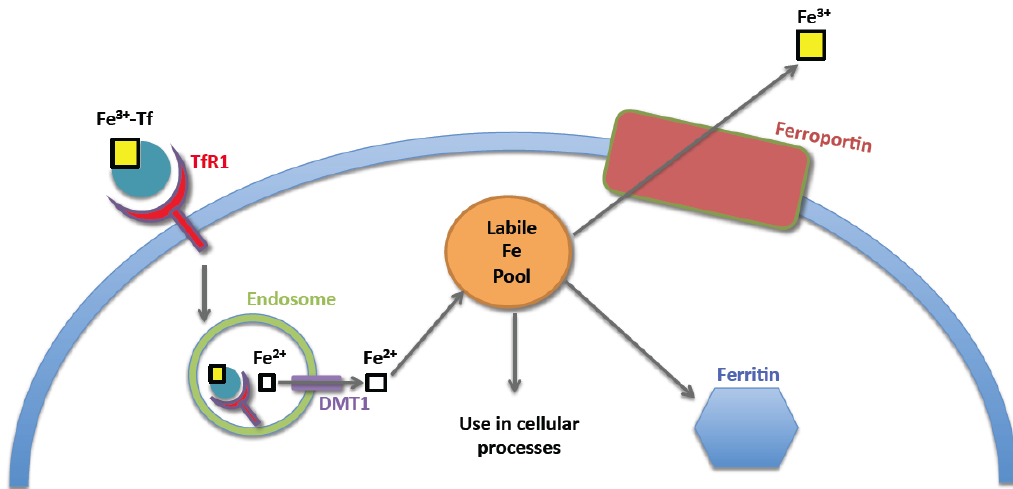
Figure 2. Cellular iron metabolism. Iron laden transferrin is taken up by the cell via clathrin-mediated endocytosis of transferrin receptor-1 (TfR1). Acidification of the resultant endosome releases iron from TfR. Iron is transported out of the endosome via DMT1, and becomes part of the labile iron pool. Iron may then be used in a variety of cellular processes, stored as ferritin, or exported out of the cell via